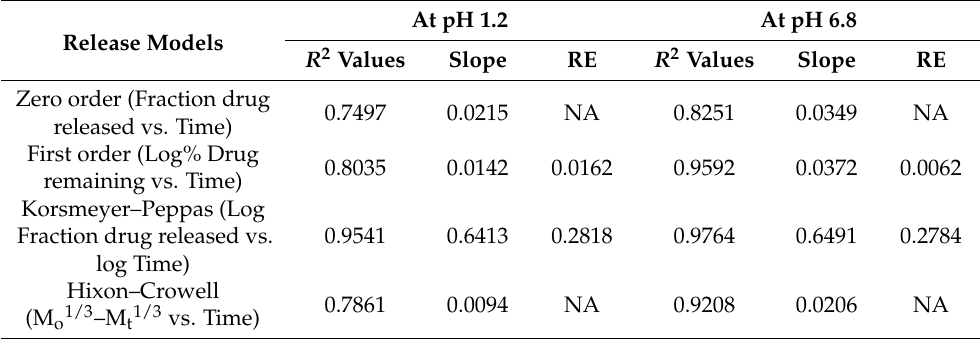
Table 3. Release models applied to check the release kinetics of OLA from the OLA-NCs-2 at two pH